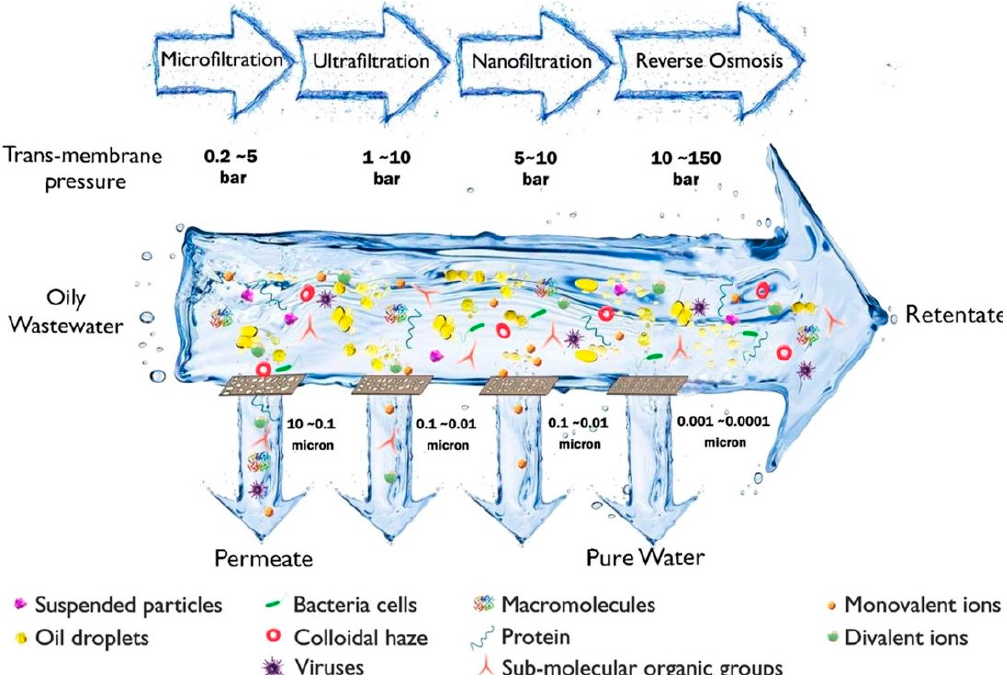
Figure 8. Schematic representation view of pressure-driven membrane technologies (cross-flow mode) for the treatment of oily wastewater (Reprinted with permission from Ref. [137], 2022, Elsevier).